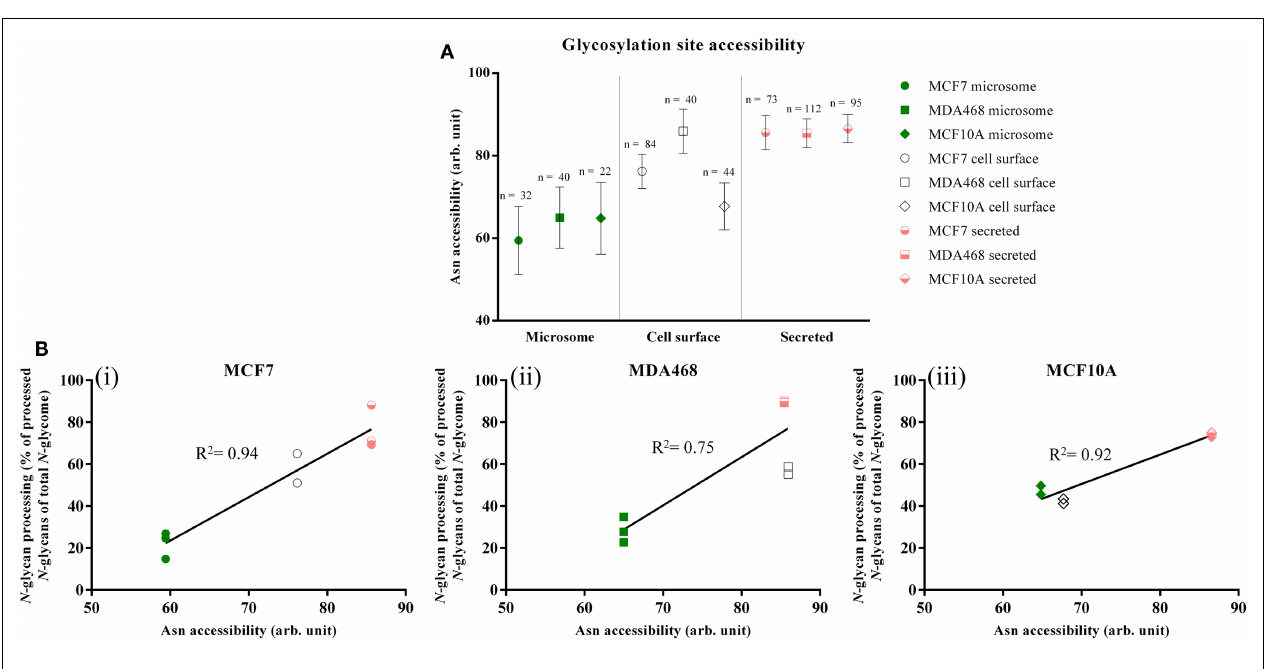
N -glycosylation processing as measured by the more processed N -glycan types (hybrid, complex, and paucimannose) as a molar proportion of the total N -glycome for the three subcellular fractions. High correlation coefficients ( R 2 ) indicate strong